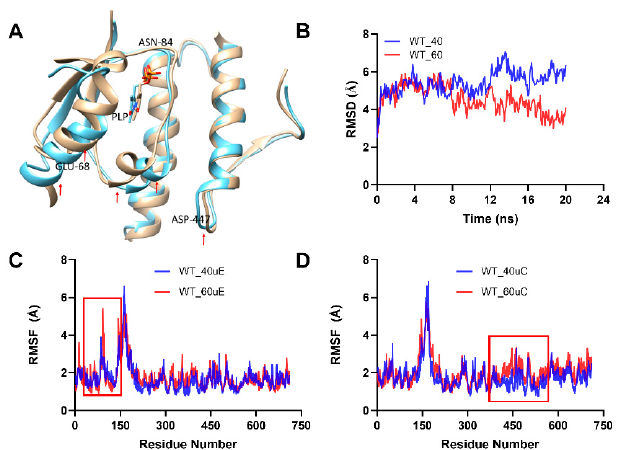
Figure 6. Analysis of thermal-induced structural alterations for the WT. ( A ). This showed the structural variations for the aligned dimer unit involved interactions for the WT at 40 °C and 60 °C, respectively. ( B ). RMSD for the backbone at 40 °C and 60 °C. ( C , D ). This showed the RMSF of the two interacting SmcadA units (C and E) at 40 °C and 60 °C, respectively. Analysis of the backbone RMSD for the Ser512Ala variant showed that the mutant had lower RMSD values at 40 °C (Ser512Ala_40) compared to that at 60 °C (Ser512Ala_60), particularly before 8 ns was significantly lower (Figure 7B). The results further indicated that the RMSF at 60 °C (Ser512Ala_60uE) was significantly higher than that at 40 °C (Ser512Ala_40uE), as shown in Figure 7C by the red rectangle. This suggested that increased temperature caused undesirable unfolding of the protein residues, confirming observed changes in the orientation of residues near Glu65 (Figure 7A). The protein unit C RMSF also showed increased instability of the C-terminal residues (350–600), marked with the red rectangle at 60 °C (Ser512Ala_60uC) compared to that at 40 °C (Ser512Ala_40uC), as shown in Figure 7D. Moreover, these highlighted regions constitute highly conserved residues of the two domains involved in PLP binding. Thus, increased flexibility and instability due to elevated temperatures contributed to the altered interactions of PLP and protein residues at 60 °C [31].